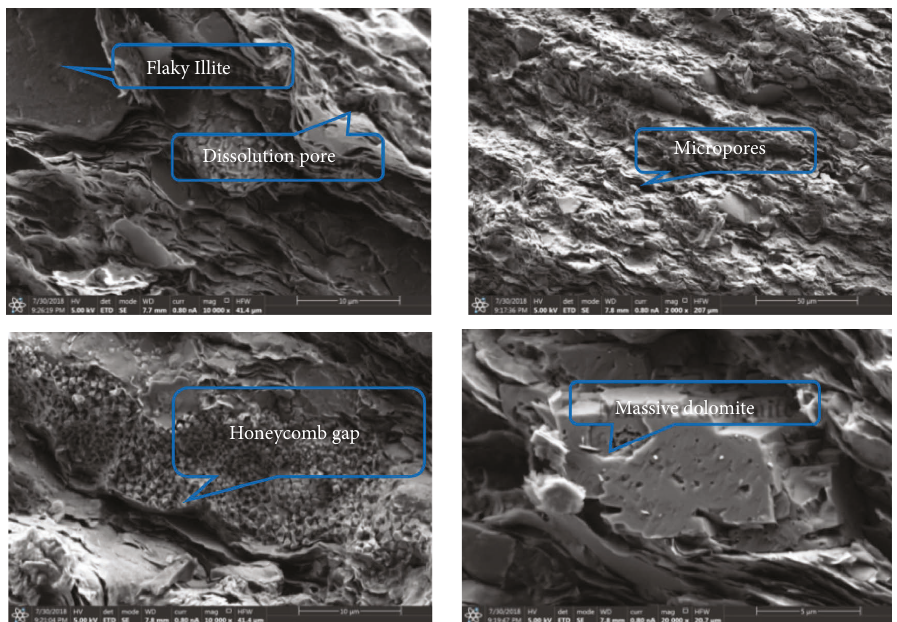
Figure 2: SEM of rock